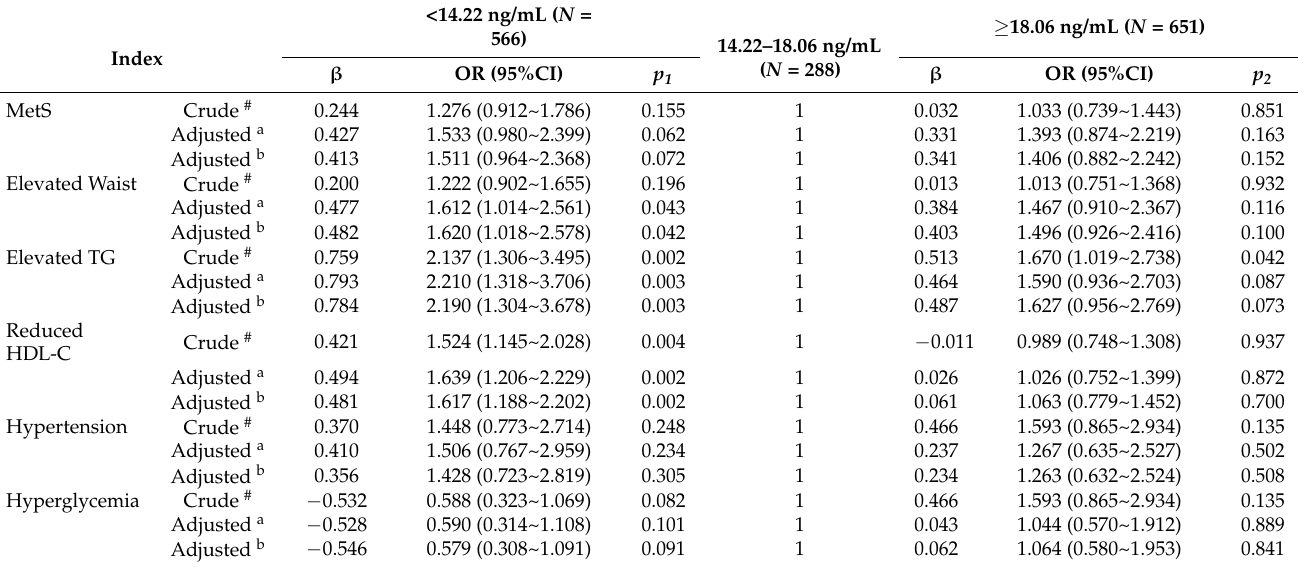
Table 6. Odds ratios for MetS and its components according to vitamin D